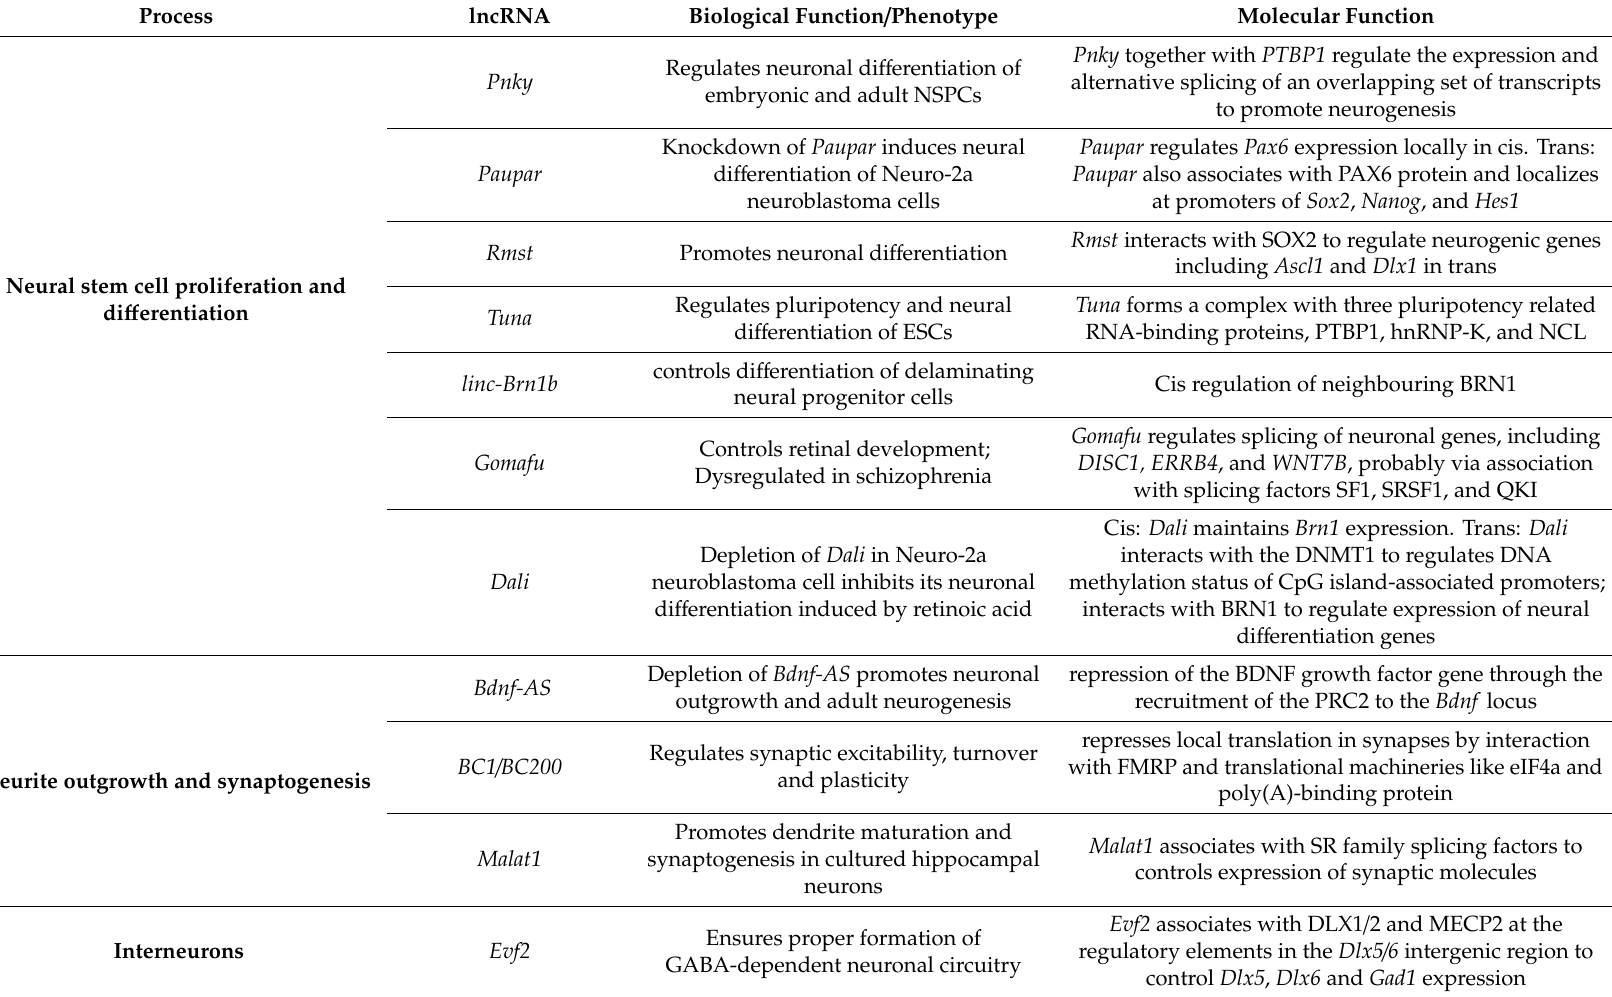
Table 1. List of lncRNAs with a putative function in neurogenesis and neuronal circuit